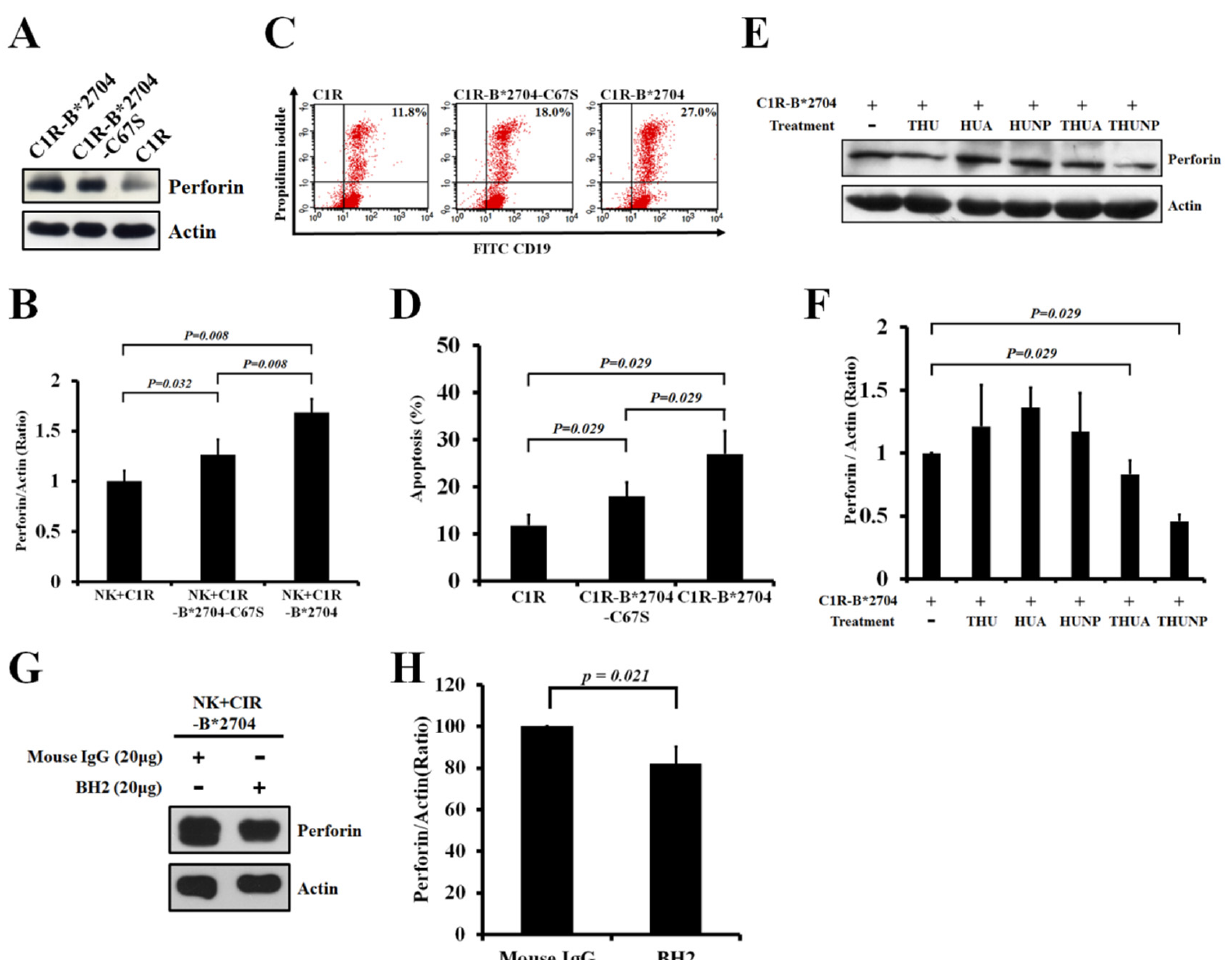
Figure 2. The effect of co-culturing with C1R, C1R-B*2704 C67S, or C1R-B*2704 cells on the NK cell-mediated cytotoxicity. ( A ) Western blotting analysis of the perforin expression in NK-92MI cells co-cultured with C1R, C1R-B*2704 C67S, or C1R-B*2704. An aliquot (50 μ g) of extracted pro- teins was separated with SDS-PAGE and analyzed via Western blotting, probed for actin and per- forin. ( B ) The ratio of perforin/actin averaged from four independent experiments in Figure 2A is plotted. ( C ) Analysis of NK-92MI-mediated cytotoxicity via flow cytometry. The apoptotic cells and C1R cells were stained with propidium iodide and anti-CD19 antibodies, respectively. ( D ) The percentages of apoptotic cells induced by NK-92MI-mediated cytotoxicity averaged from four in- dependent experiments in Figure 2C are plotted. ( E ) The effect of co-culturing with C1R-B*2704 cells that have been pre-treated with THU, HUA, HUNP, THUA, or THUNP on the perforin ex- pression of NK-92MI. ( F ) The ratio of perforin/actin averaged from four independent experiments in Figure 2E is plotted. The ratio of perforin/actin obtained from the control was set to one. ( G ). The effect of co-culturing with C1R-B*2704 in the presence of BH2 or mouse IgG on the perforin expression of NK-92MI. ( H ) The ratio of perforin/actin averaged from four independent experi- ments in Figure 2G is plotted. The ratio of perforin/actin obtained from the control was set to 100%. 3.3. The PI3K/AKT Signaling of NK-92MI Cells were Activated by Co-Culturing with C1R-B*2704 Cells Recruitment of PI3K to phospho-Tyr of ITIM in the cytoplasmic tail of KIR3DL2 has been reported, in turn activating the PI3K/AKT signaling of NK cells [21]. Thus, we ana- lyzed whether the co-culture of NK-92MI cells with C1R-B*2704 or C1R-B*2704 C67S cells can activate the PI3K/AKT pathway. Figure 3A,B show that the PI3K/AKT signaling of NK-92MI cells can be activated by co-culturing with C1R-B*2704 or with C1R-B*2704 C67S cells. However, the level of the PI3K/AKT pathway activated by C1R-B*2704 cells is higher than that of C1R-B*2704 C67S cells. In the presence of the PI3K inhibitor (LY294002), activation of PI3K/AKT signaling by co-culturing with C1R-B*2704 cells in NK-92MI cells was significantly suppressed (Figure 3C,D) and the perforin expression was also down-regulated (Figure 3E,F).